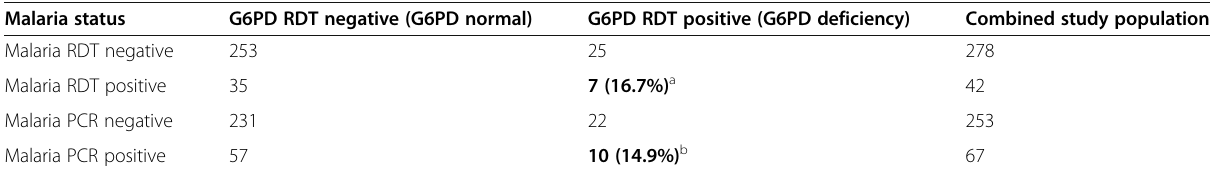
Table 3 Proportion of G6PD deficiency among malaria-infected populations in the combined sample of two national groups, Myanmar (2016-2018)